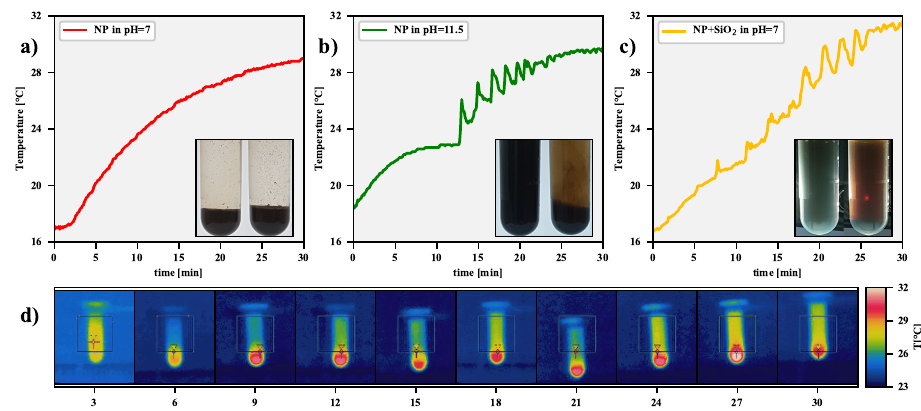
Figure 6. The plots in the top row show the surface temperature changes during the RFMH process for various NP suspensions: ( a ) bare NPs in solution at pH = 7, ( b ) bare NPs in solution at pH = 11.5, and ( c ) silica-coated NPs in solution at pH = 7. The insets of the individual panels show two tubes with an untreated sample on the left and treated by the RFMH on the right. As the solution was the least transparent for the NPs + SiO 2 suspension, both samples were additionally illuminated from behind. In this case, the red spot on the RFMH treated tube indicates that due to the large number of small agglomerates in the supernatant, short wavelengths of visible light are highly scattered. The bottom row ( d ) presents the time-lapse sequence of IR images for the NPs suspension at pH =